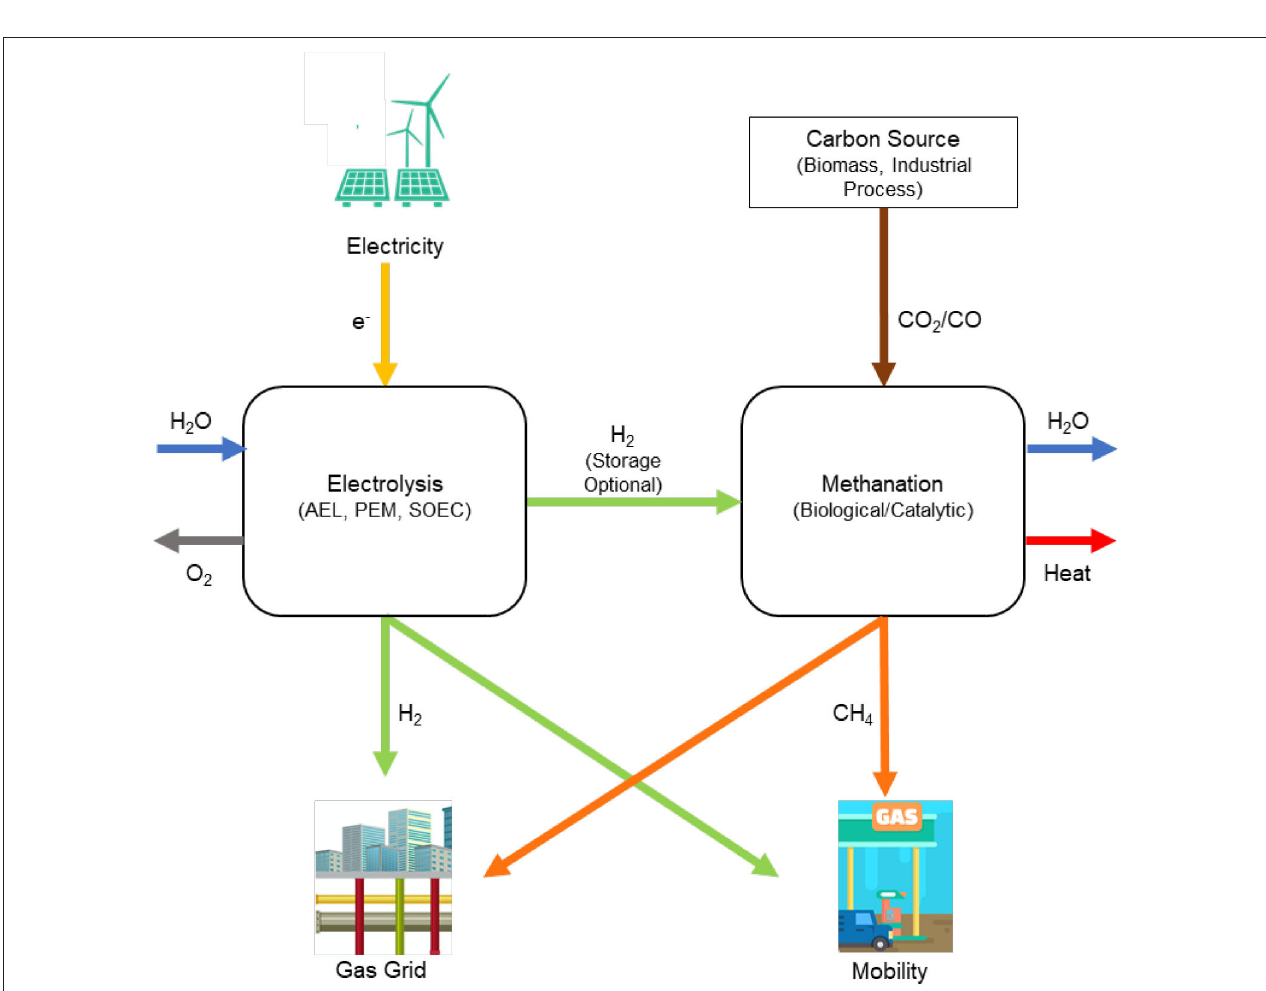
use, setting the pace for a safe and sustainable global society” (European Commission,